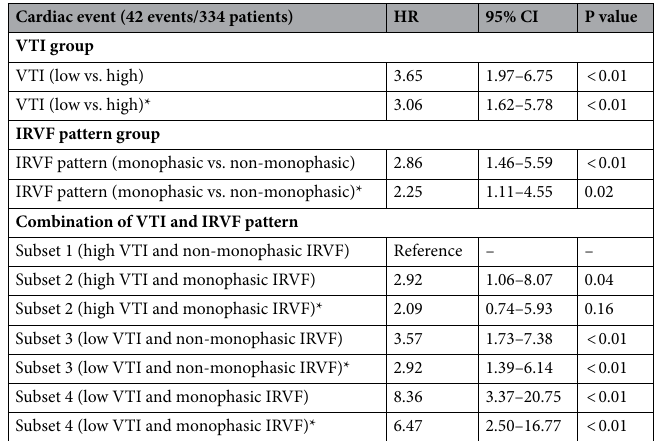
Table 3. Cox proportional hazard model of cardiac events (factors in parameters of renal ultrasonography). HR hazard ratio, CI confidence interval, VTI velocity time integral, IRVF intrarenal venous flow. *Adjusted: adjusted for age and